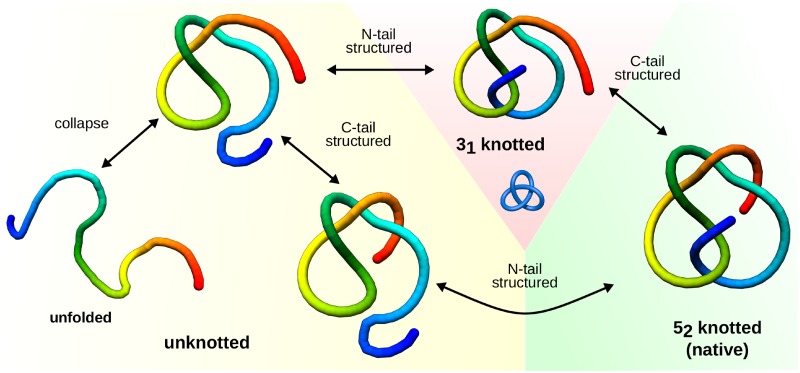
Schematic representation of possible folding pathways of UCHs.The folding starts with a collapse, next, depending on which terminus becomes structured first, two topologically distinct pathways are possible. Lower arrows: the pathway where N-terminus is structured after C-terminus (FN), protein self-ties in one step (direct 01 → 52 transition). The upper arrows: pathway where C-terminus is structured last (FC)—the protein follows 01 → 31 → 52 pathway, where in the 31 knotted intermediate the N-terminus is in its native position, while C-terminus is not. Different background denotes different topology.